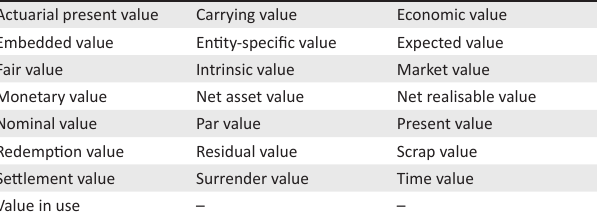
TABLE 1: Terminology used in International Financial Reporting Standards to specify a type of value (listed